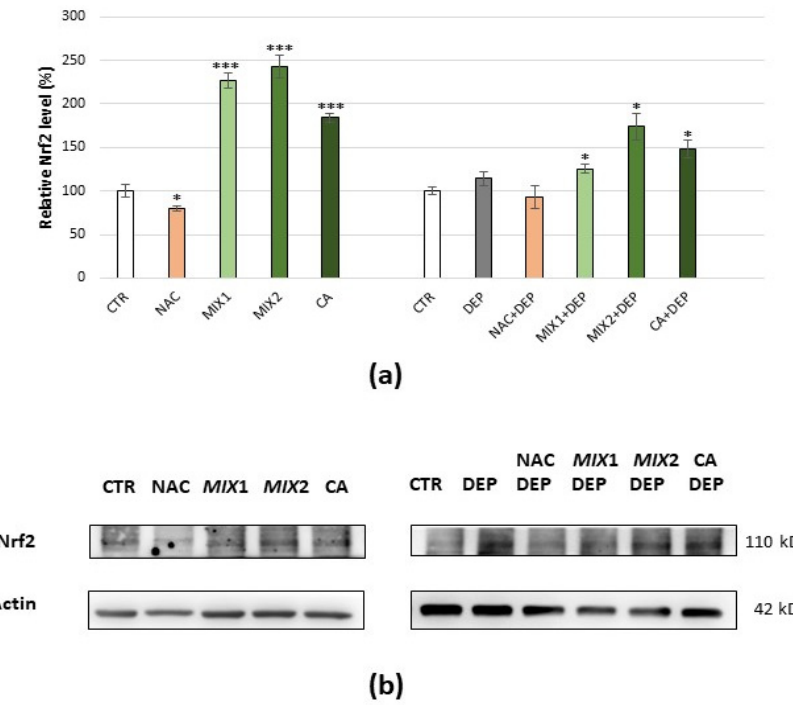
Figure 7. Immunoblotting analysis of Nrf2. ( a ) Protein was evaluated following cell treatment carried out only with antioxidants (5 mM NAC for 24 h, 0.5 µ M Mix 1 or 1 µ M Mix 2 or 1 µ M caffeic acid (CA) for 48 h), only with pro-oxidant (25 μ g/mL DEPs for 12 h), and finally with the different antioxidants and subsequent exposure to DEPs. Protein was normalized for the corresponding β -actin signal in each lane, and expressed as a percentage of the control. Values represent mean ± SE obtained from three independent experiments. * p < 0.05 versus control, *** p < 0.001 versus control. ( b ) Corresponding representative immunoblotting images.